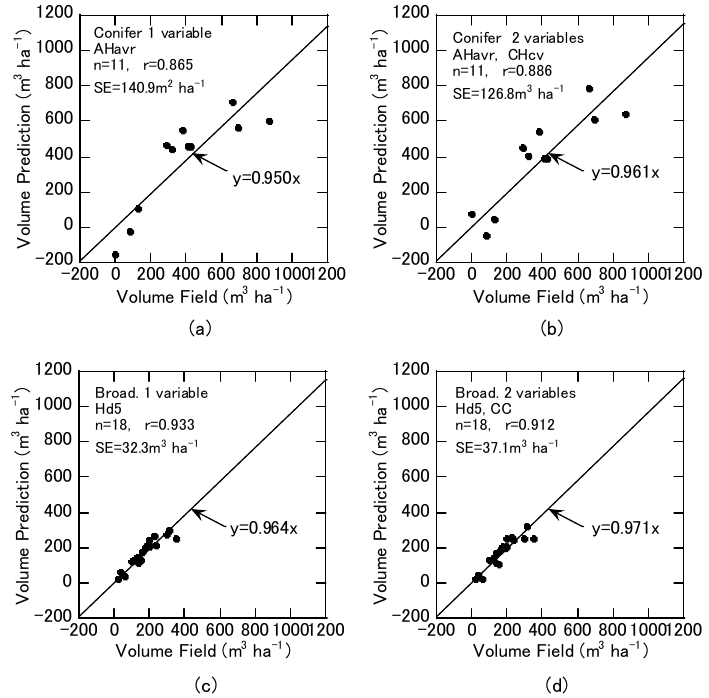
Figure 5. Validation results of SV prediction based on comparison of predicted and field SV. ( a ) One- and ( b ) two-variable models for evergreen coniferous forests, and ( c ) one- and ( d ) two-variable models for deciduous broadleaved forests.